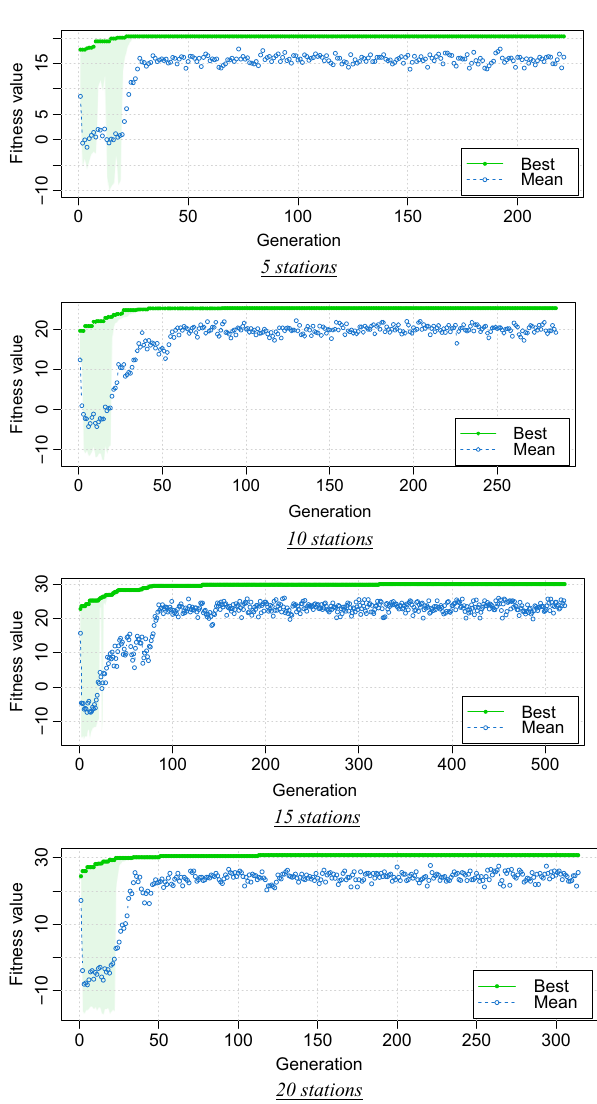
Fig. 4 Best fitness value among the current and all previous generations vs average fitness values per generation of the